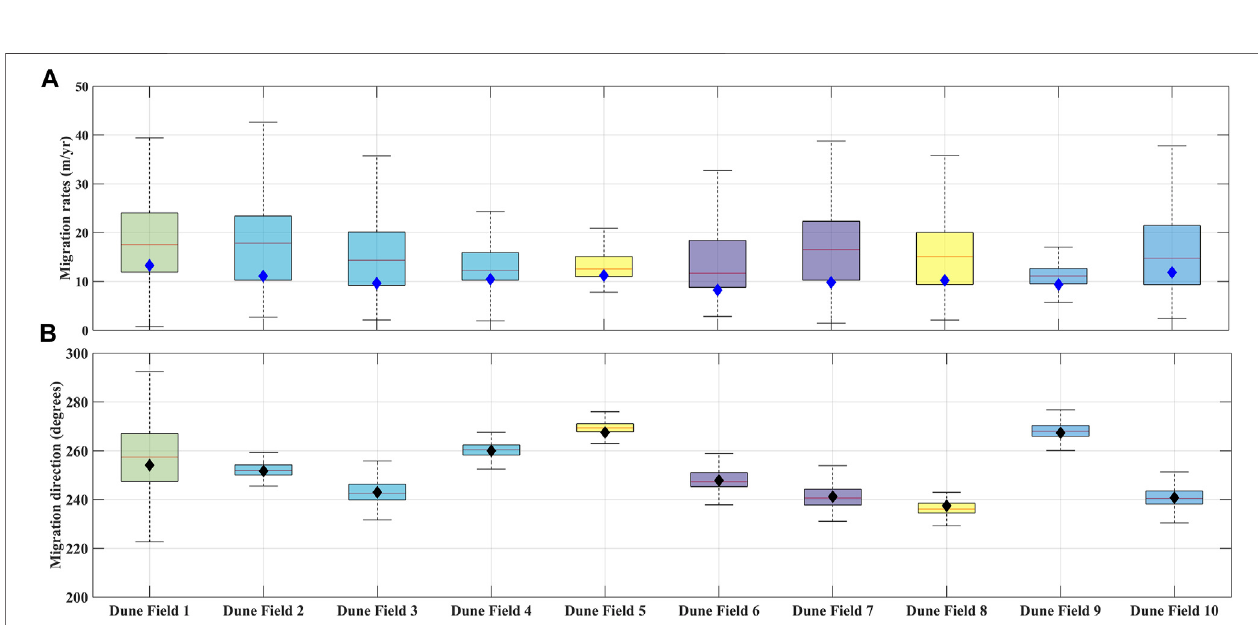
FIGURE 8 | Boxplots of the AAM (A) , PMD (B) , and MSC (C) . The box plots were plotted for 4,000 pixels belonging to ten dune fi elds (see Figure 1 ). The outliers were discarded from the visualization; however, they were considered in estimating the median, and the interquartile ranges.